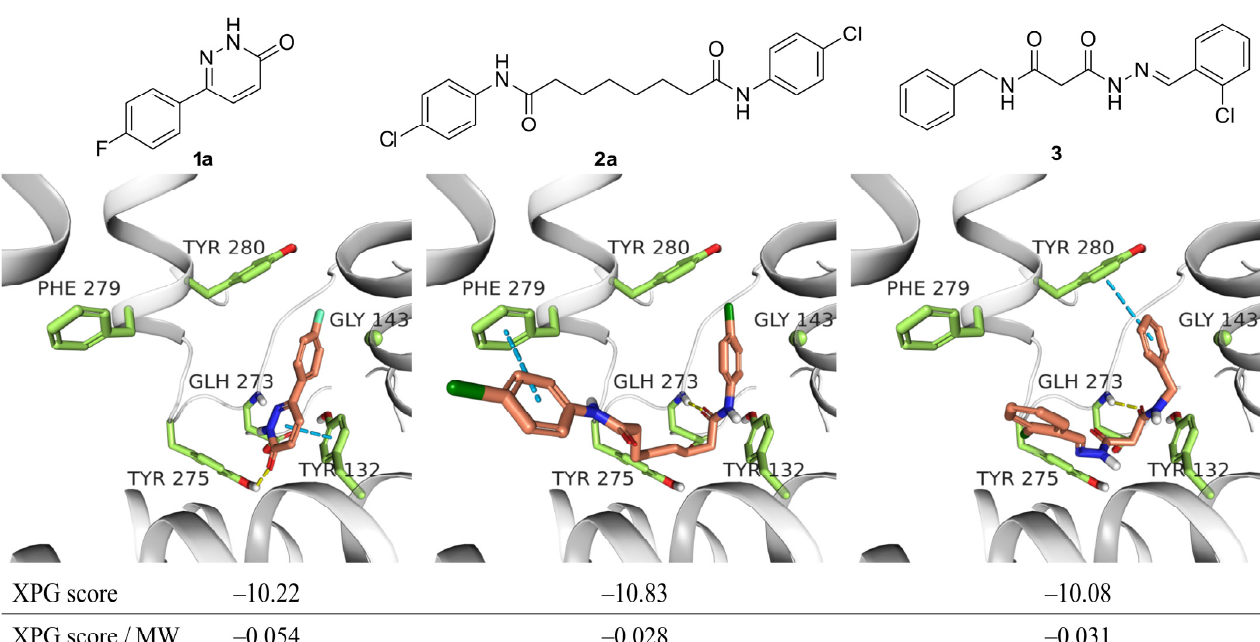
Figure 1. Structures, top-scoring docking poses and glide scores of compounds 1a , 2a , and 3 (orange sticks); protein (grey cartoons), interacting residues (green sticks), hydrogen bonds (yellow dashes), and π - π interactions (cyan dashes).